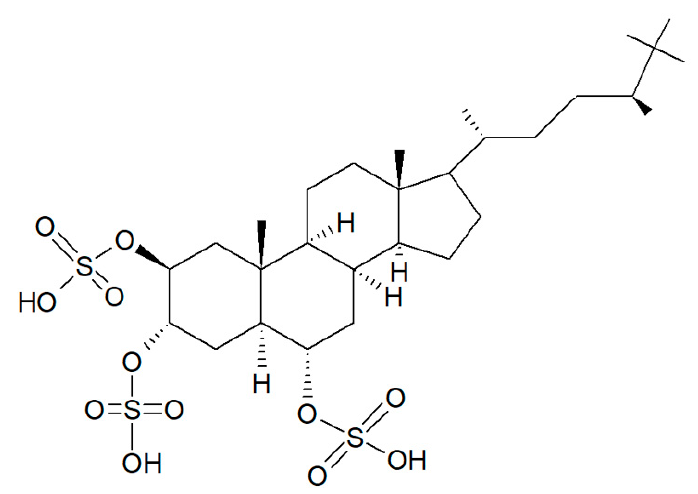
Figure 11. Structure of halistanol sulphate.